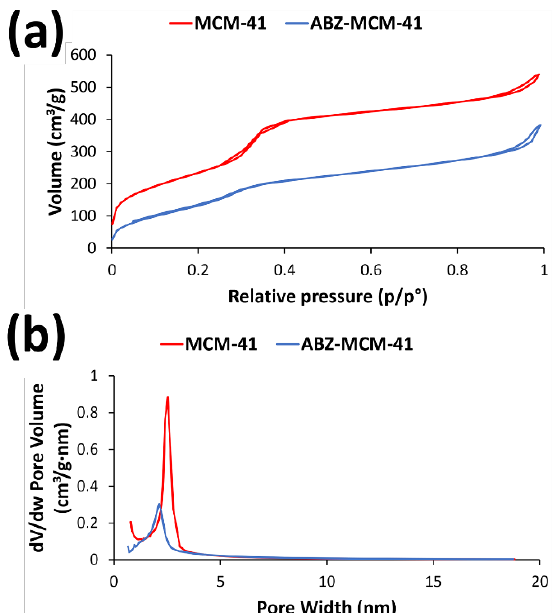
Figure 5: N2 adsorption/desorption isotherms of Mobil Composition of Matter No. 41 (MCM–41) and albendazole (ABZ)-MCM-41 NPs for measur- ing their (a) surface volume and (b) pore size. As the results showed, a sharp increase in the N2 up- take around p/p* 0.3 occurred, which could be at- tributed to capillary condensation in cylindrical pores of MCM-41 and ABZ-loaded MCM-41 NPs. Also, the surface volume and pore size of the car- rier decrease after drug loading. However, this de- crease does not affect the mesoporous structure of this carrier.